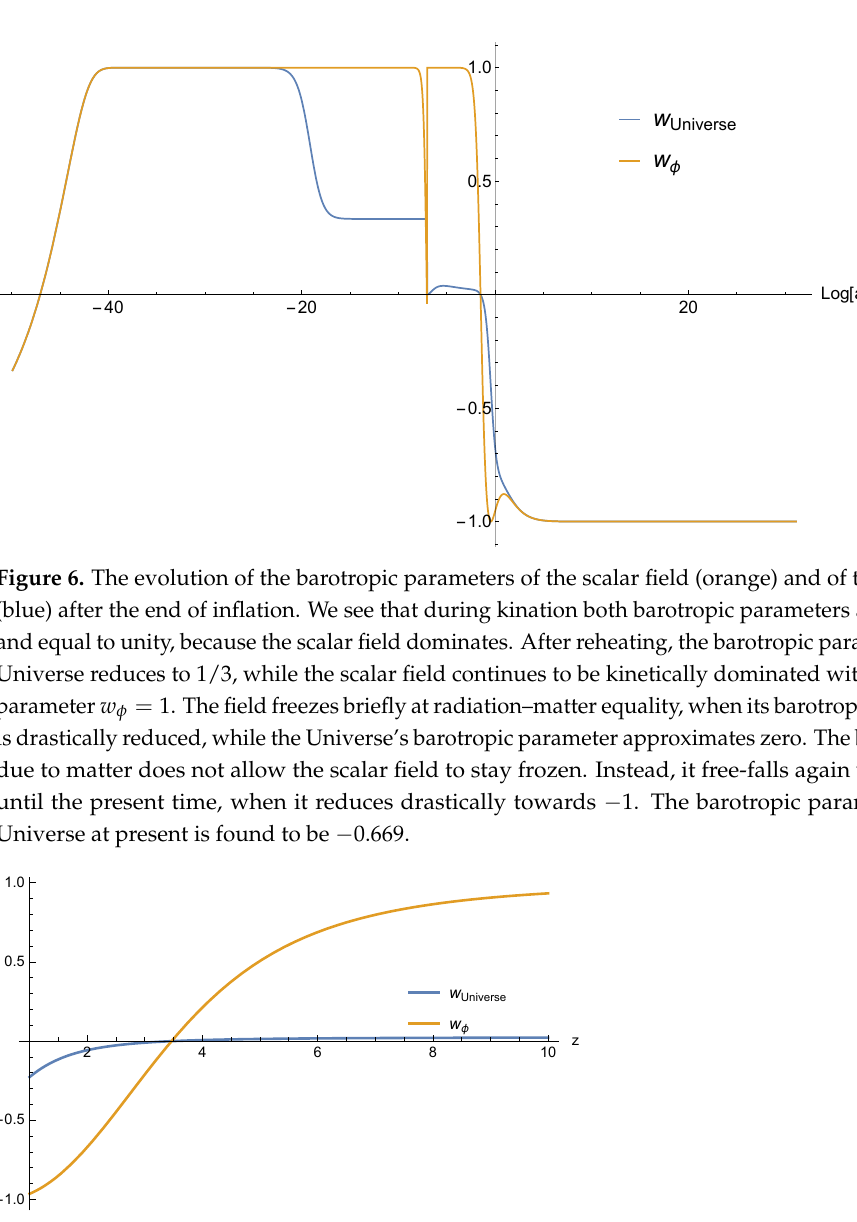
Figure 7. The evolution of the barotropic parameters of the scalar field (orange) and of the Universe (blue) as a function of redshift near the present. It is evident that w ≈ 0 near z (cid:39) 4, when galaxy formation